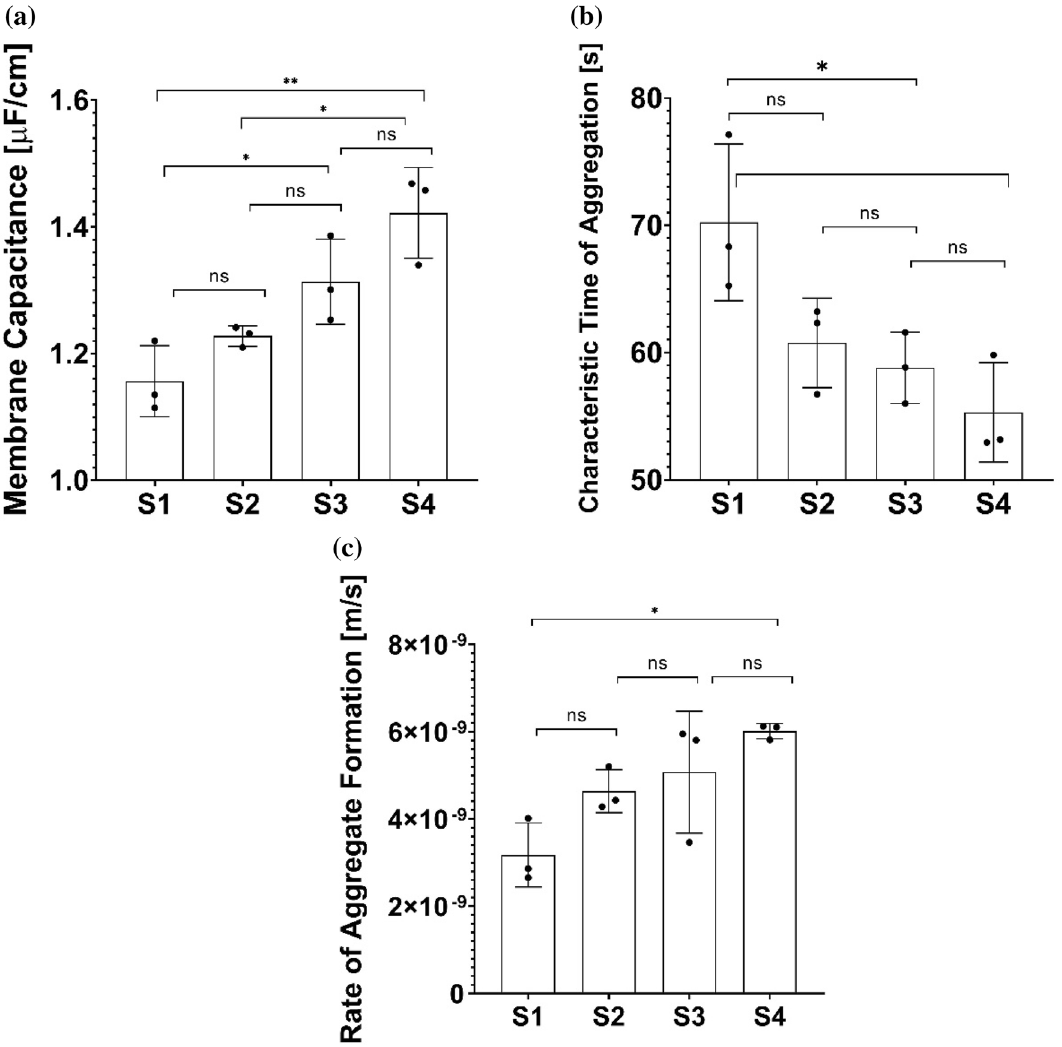
Figure 6. Analytical model parameters ( C mem ( a ), t agg ( b ), ν agg ( c )). The parameters are estimated using the ε l ( t ) data until time point t = 100 s . Results are shown using box plots. One-way ANOVA with Tukey’s post-hoc test is used for multiple comparison. Probability values are indicated on figures by asterisks, as follows: *p < 0.05; **p <